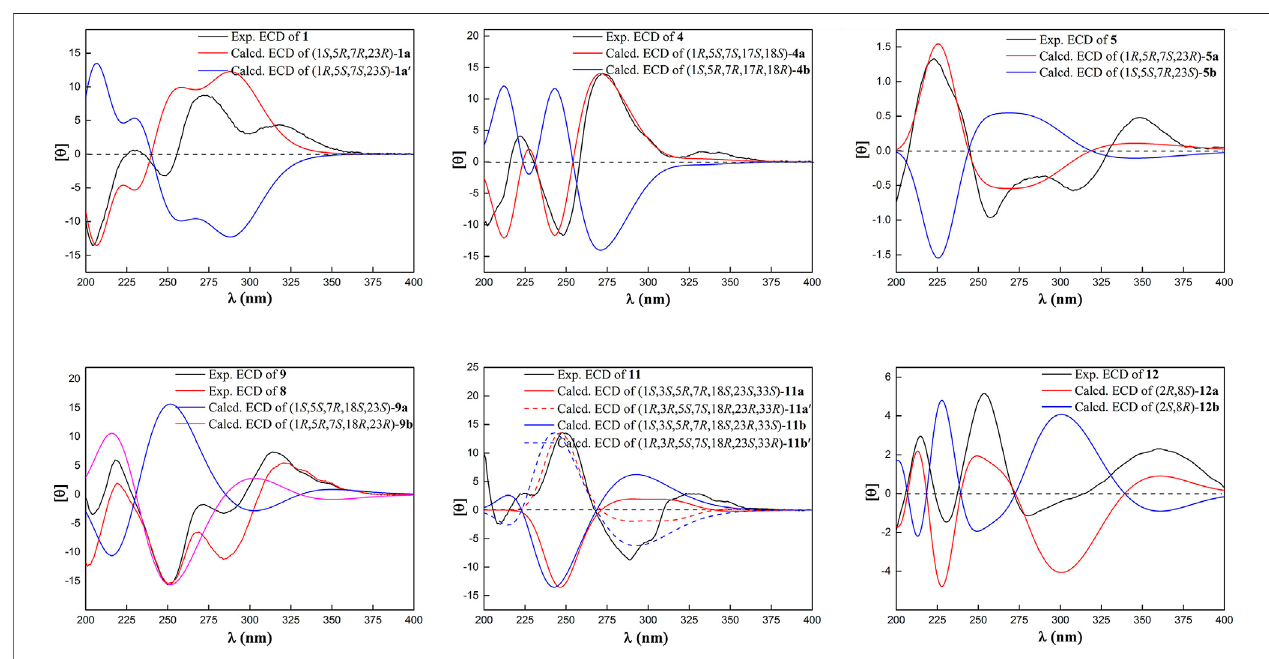
FIGURE 4 | Calculated and experimental ECD spectra of 1 , 4 , 5 , 8 , 9 , 11 , and 12 .